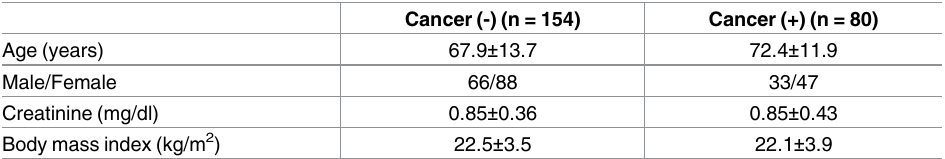
Table 1. Patient